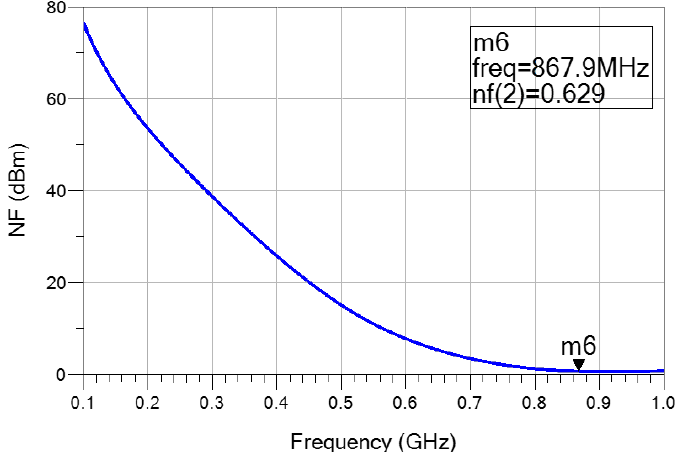
Figure 9. Simulation of the noise figure NF at 868 MHz.